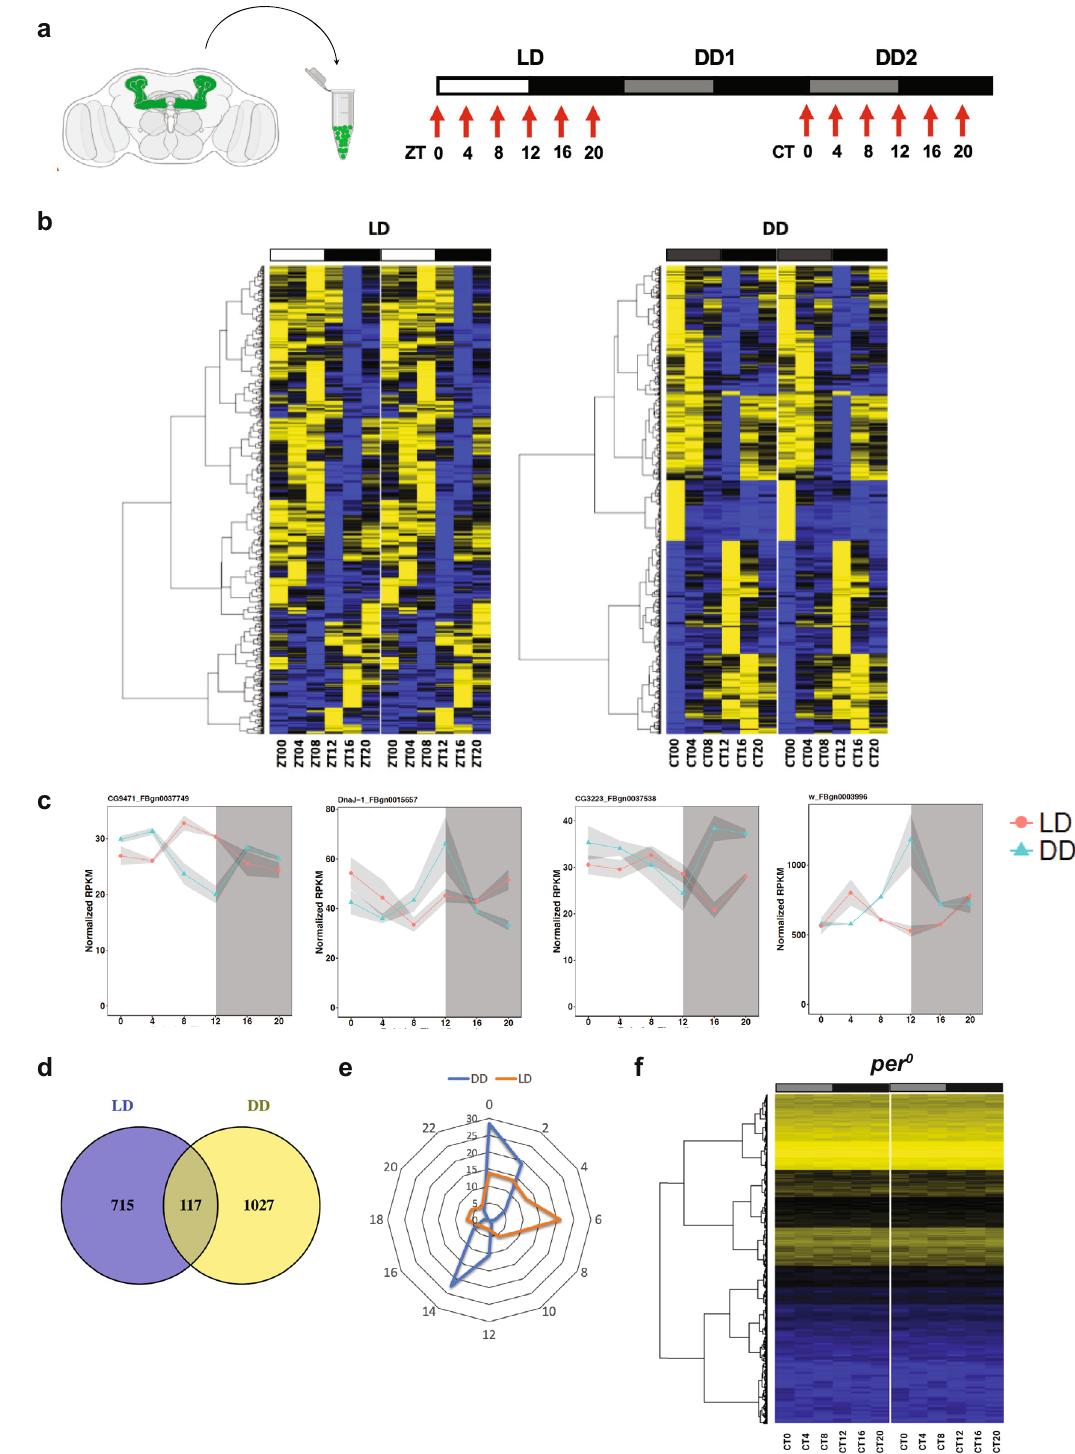
Fig. 1 Circadian gene expression pro fi ling of MB neurons. a Schematic representation of the circadian MB neuron cell-sorting RNA-seq assay. b Heatmap depicting the genes expressed with circadian oscillations during LD and DD in the MB as identi fi ed using the nonparametric JTK_cycle algorithm with a cut- off of p.adj < 0.05. Each row represents a gene, and rows are ordered by hierarchical clustering using the ward.D2 method. Yellow and blue colors indicate high and low relative expression levels, respectively. c Examples of RNA-seq pro fi les of cycling genes in LD (red) and DD (blue). X -axis indicates ZT or CT. The values are the mean of the normalized RPKM± SEM. d Venn diagram depicting the number of genes expressed rhythmically during LD and DD in the MB. e Circular plot representing the peak phases of circadian gene expression in LD (red) and DD (blue). The number on each circle indicates the % of cycling genes peaking at a given ZT or CT. f Heatmap representation of genes expressed in DD in MB neurons of per 0 fl ies. Data are analyzed and plotted as in b . No gene with a 24 h periodicity was identi fi ed using JTK_cycle with a cut-off of p.adj <